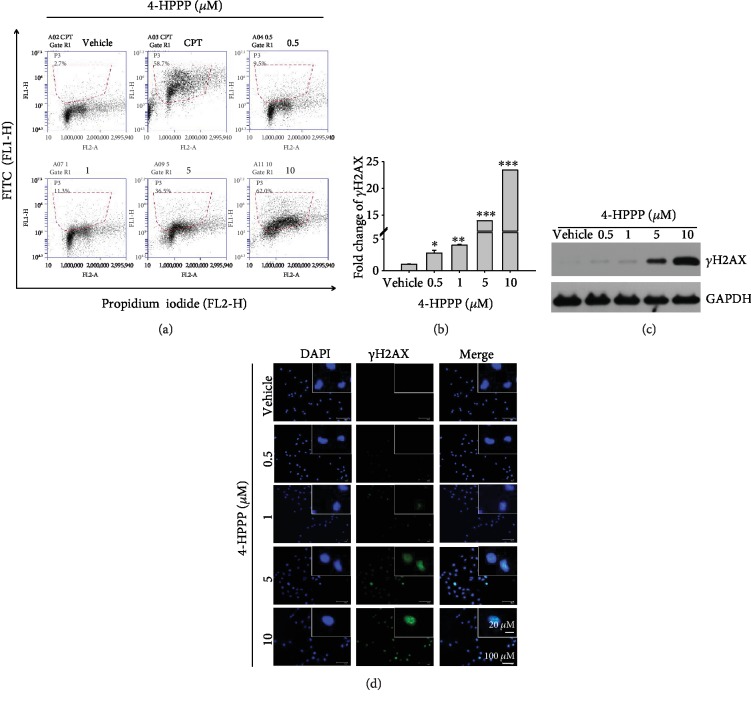
Assessment of DNA damage induced by 4-HPPP. (a) H1299 cells were administered the indicated concentrations of 4-HPPP for 48 h. Afterward, 4-HPPP-induced DNA damage was detected using a flow cytometry-based γH2AX detection assay. The green fluorescence of FITC (FL1) indicates the γH2AX-positive population (R1 region). The data showed that 4-HPPP increased the phosphorylation of γH2AX, a marker of DNA damage, in a dose-responsive manner. (b) Quantification analysis of (a). γH2AX was observed in H1299 cells following 4-HPPP treatment at concentrations from 0.5 to 10 μM by the Western blotting assay (c) and immunofluorescence assay (d). The data are presented as the mean ± SD. ∗p < 0.05; ∗∗p < 0.005; ∗∗∗p < 0.001. Scale bar: 100 μm.